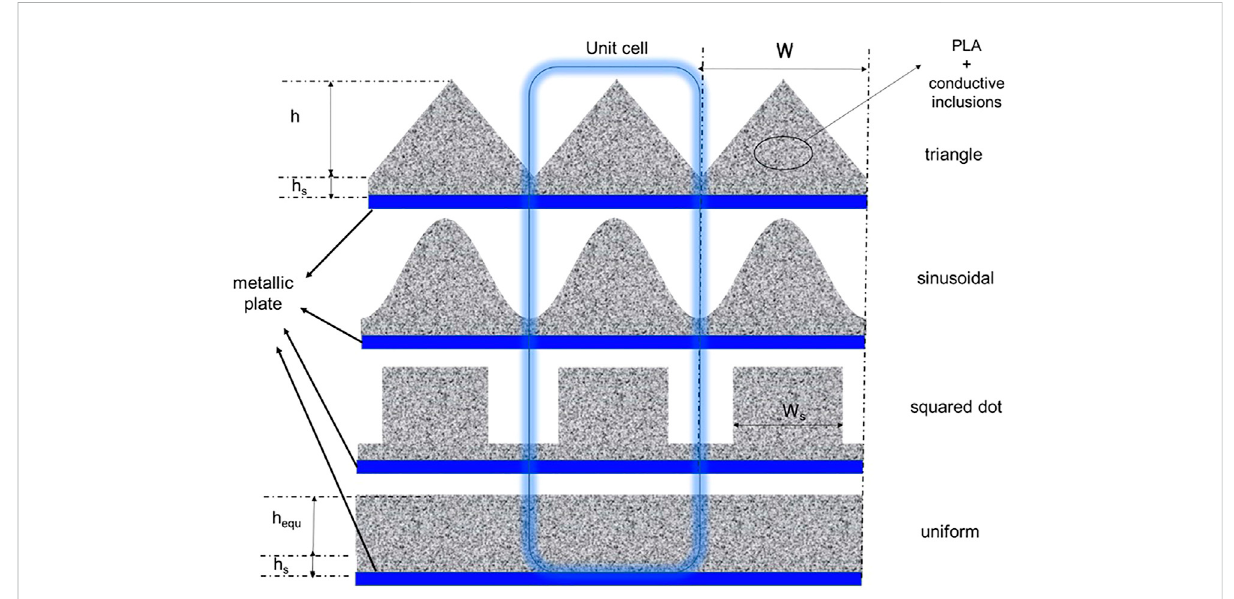
FIGURE 1 Geometry considered for the simulation of corrugated absorbers using CST software. The central blue-shaded box indicates the unit cell considered for each pro fi le. Each pro fi le has a periodicity W and thickness h, while a support layer ensuring the rigidity of the structure has a thickness h s .